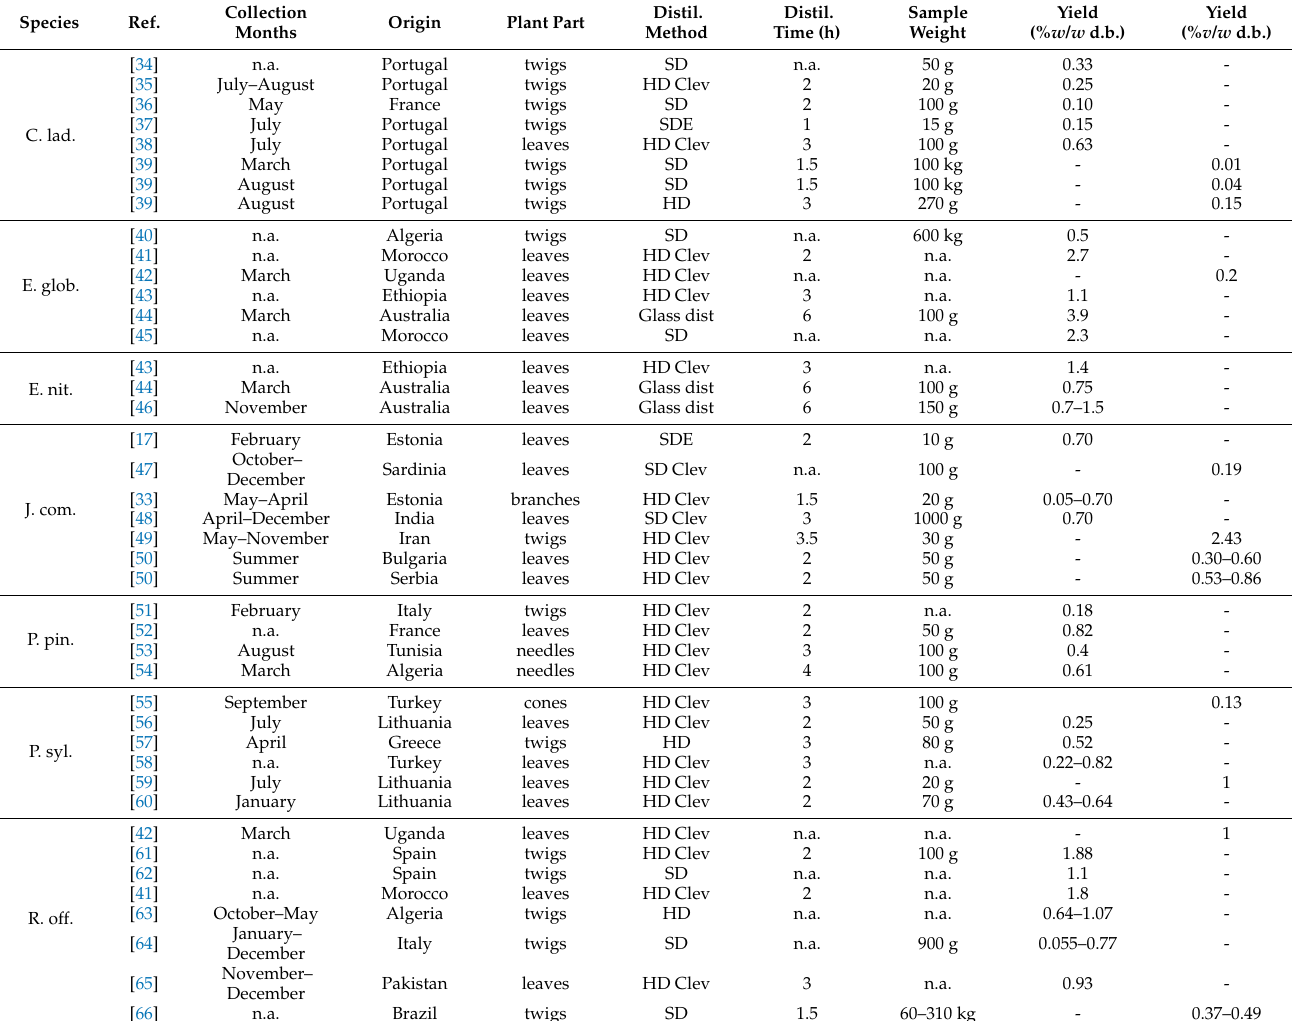
Table 3. Essential oil yields reported in previous works for the species studied. Species